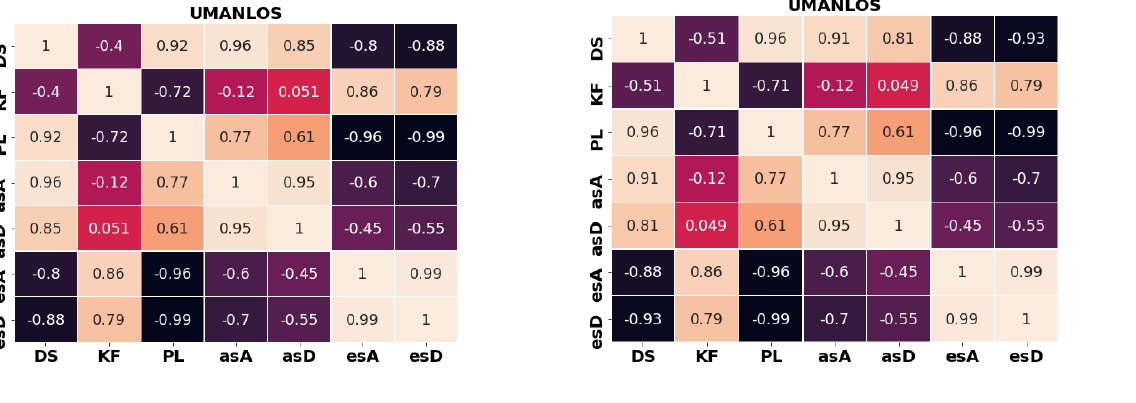
Table 1. LASSO and ElasticNet feature selection decision.